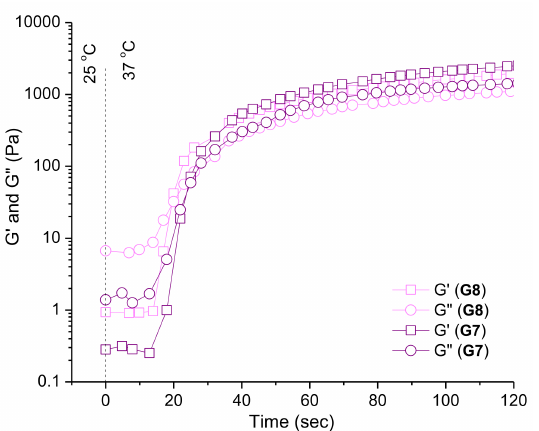
Figure 5. Variation in storage (G (cid:48) ) and loss (G (cid:48)(cid:48) ) moduli as a function of time at abrupt heating of niosome-containing formulations, G7 and G8, from 25 to 37 ◦